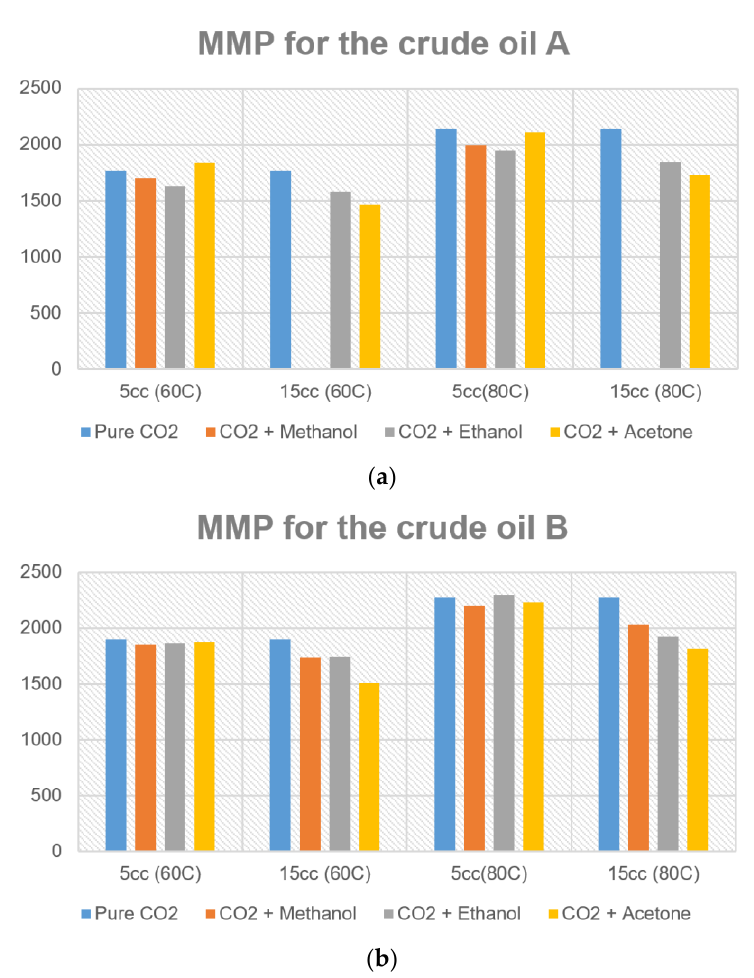
Figure 8. Oil-drop images of the mixture of CO 2 and 15 cm 3 acetone at 60 o C. 265